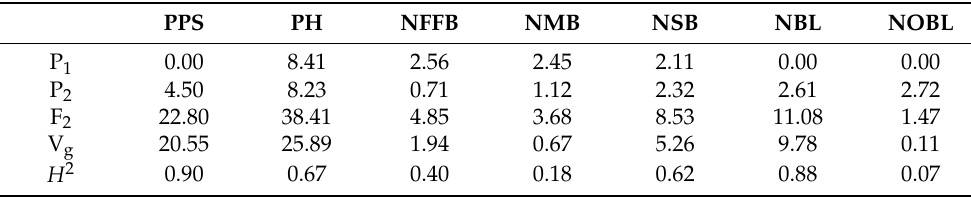
Table 2. Genetic variance and estimated broad-sense heritability ( H 2 ) of morphological and agronom- ical traits of the F 2 progeny, including their parental genotypes.